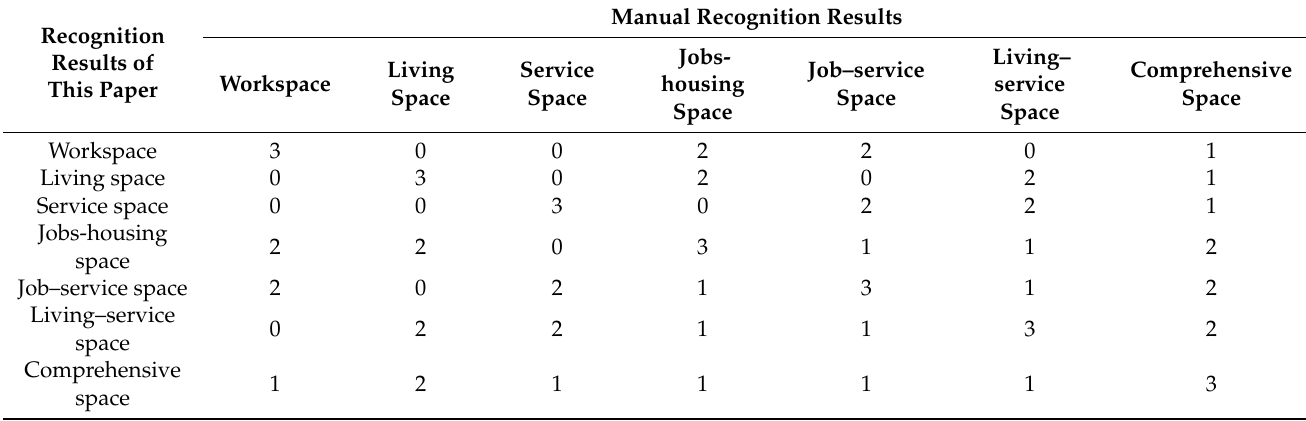
Table 2. Scoring